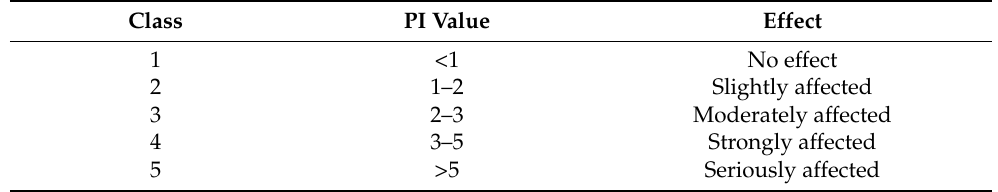
Table 2. Levels of pollution according to PI values